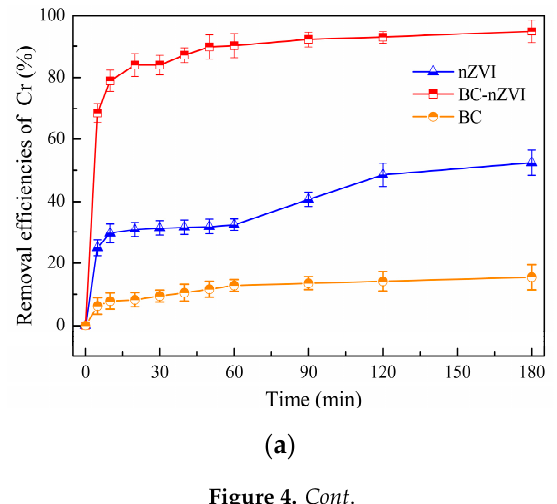
Figure 3. ( a ) Wide-scan XPS survey of BC, ( b ) wide-scan XPS survey of BC-nZVI, and ( c ) a high- Figure3. ( a )Wide-scanXPSsurveyofBC,( b )wide-scanXPSsurveyofBC-nZVI,and( c )ahigh-resolution resolution Fe 2p XPS survey of BC-nZVI. Fe 2p XPS survey of BC-nZVI.